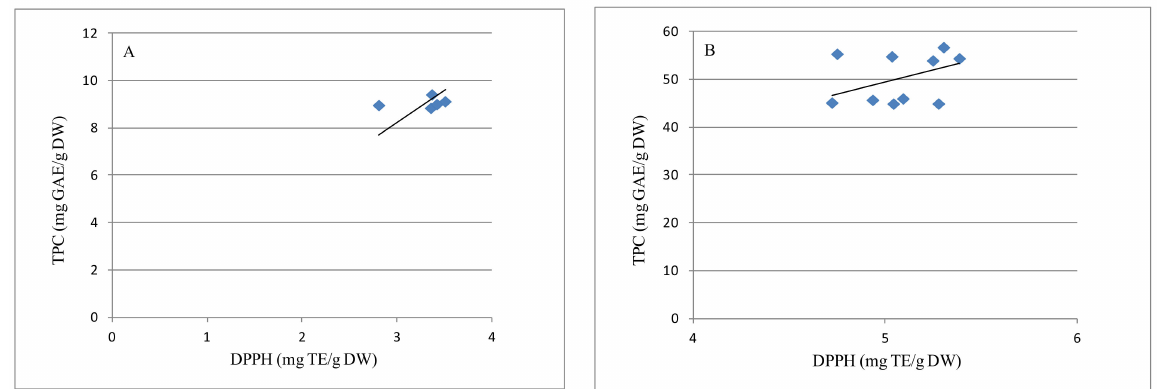
Figure 3. Regression analysis of antioxidant activity (AOA) and total phenolic content (TPC) of seeds ( A ), and shells ( B ) of chestnut (TPC in mg GAE/g dry weight; AOA in mg Trolox equivalent (TE)/g dry